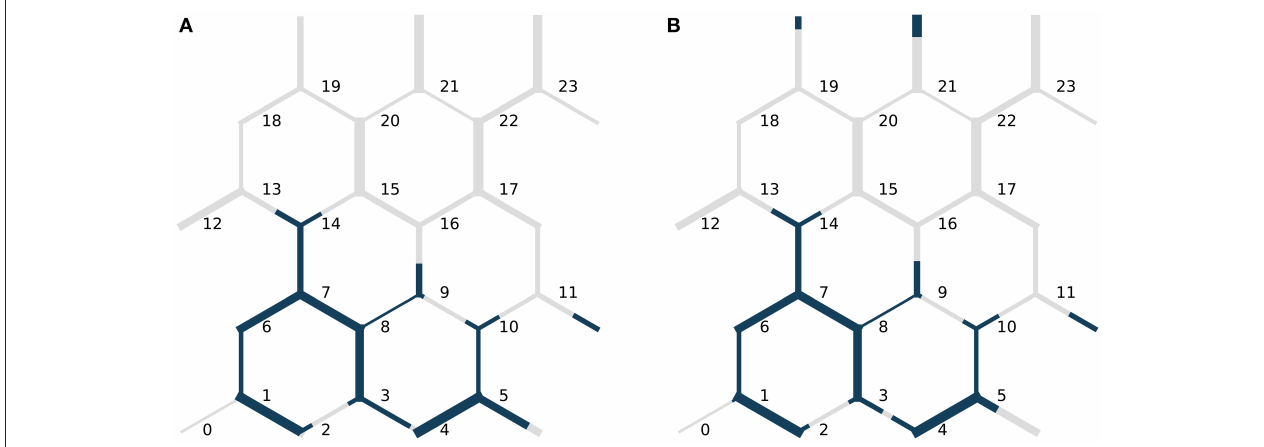
FIGURE 8 | Fluid distribution in the Haines jump case, (A) at t = 0 . 19s and (B) at t = 0 . 21s , before and after the fluid redistribution event at t ≈ 0 . 20s . The link radii are not drawn to scale with the link lengths. Node indices are indicated in black.